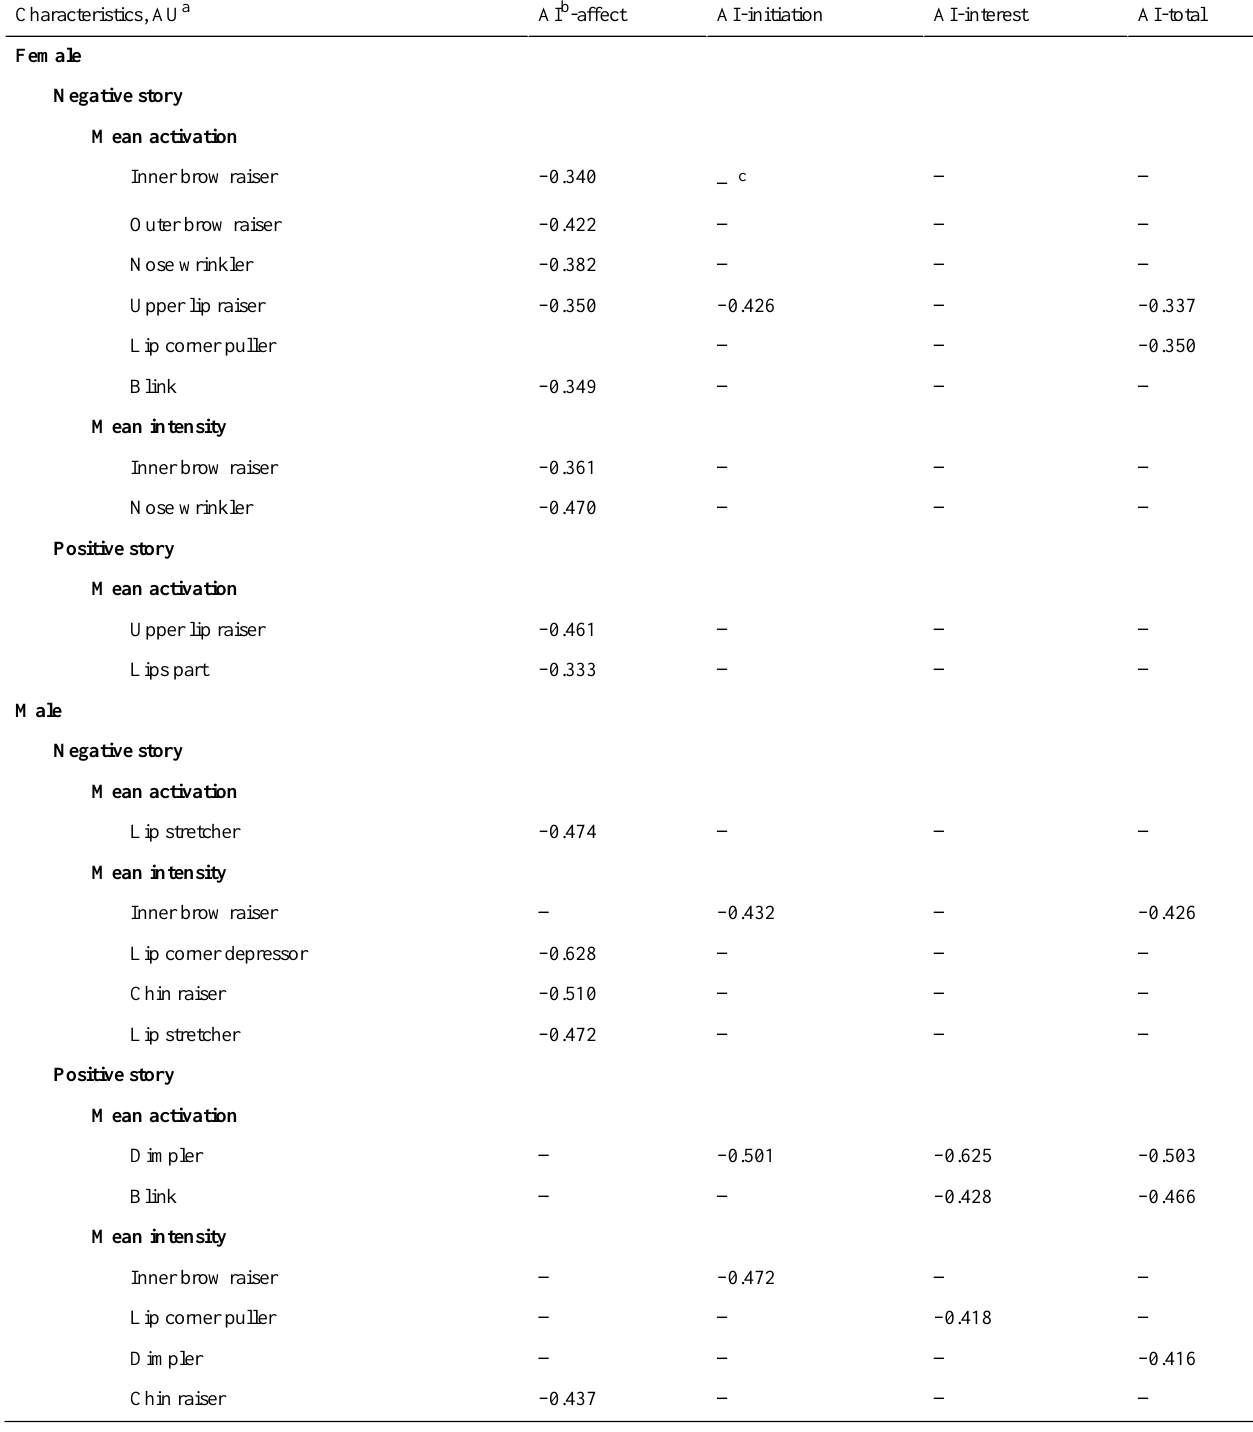
Table 3. Spearman rho correlations between action units and apathy scales for males and